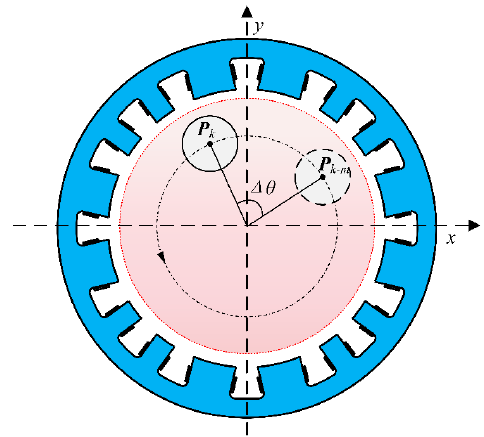
Figure 4. Rotating speed evaluation.